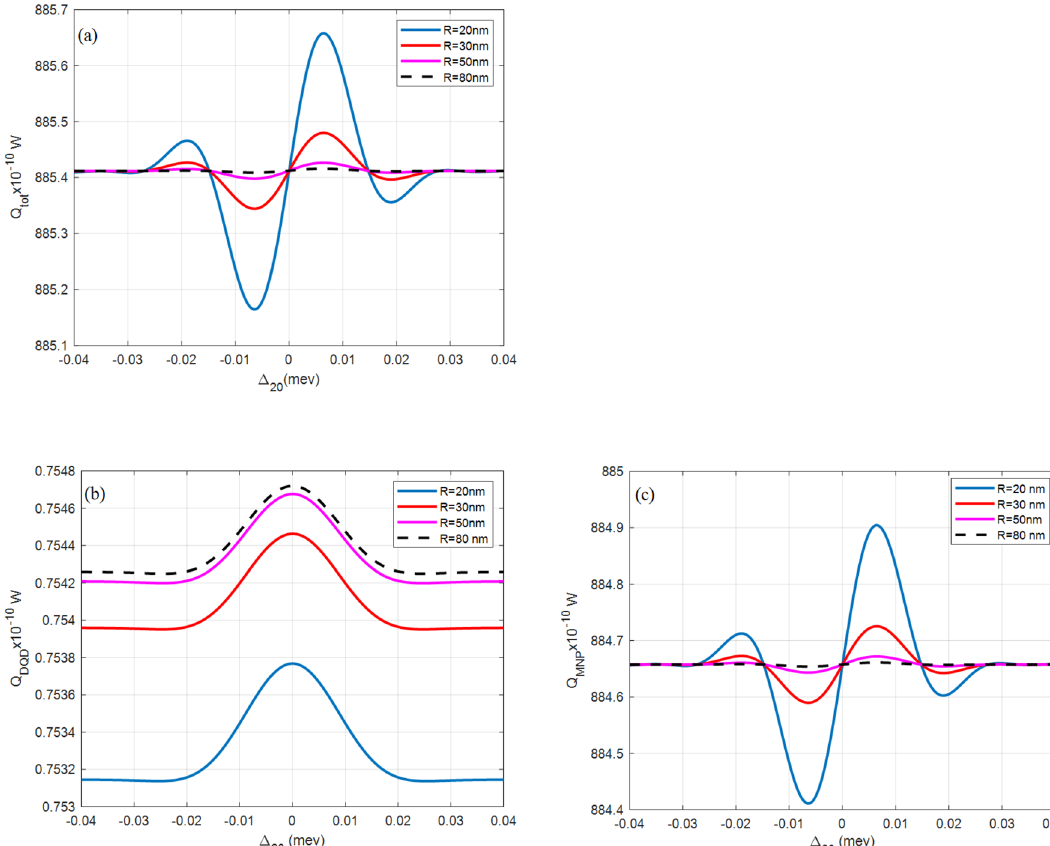
Figure 3. ( a ) The total ( Q tot ) , ( b ) DQD ( Q DQD ), and ( c ) MNP ( Q MNP ) absorption rates from the DQD-MNP hybrid system at different spacings ( R ) (the inset) with a = 10 nm, (cid:31) 0 02 = 0.09meV , (cid:31) 0 13 = 1.8GeV while the low tunneling component (pink curve) is far from them. Checking Fig. 5b and c shows that this result comes from the difference in Q DQD . Figure 6 shows Q tot at different T 23 tunneling values. A broader blue shift than that corresponds to high T 01 100 γ 0 , pink curve) the curve is inverted and reduced, referring to destruc- tunneling. At higher tunneling ( T 23 = tive interference between fields (pump, probe, and MNP polarization field). Note that this inversion is not shown in Q MNP curves while it appears in the Q DQD at tunneling less than 100 γ 0 (red curve in Fig. 6b) but not affect Q tot due to the lesser contribution of Q DQD in the Q tot . This result indicates that the synchronization between Q MNP and Q DQD is destroyed under high tunneling. Figure 7 shows Q tot at different QD sizes. Broader QD size exhibit a high absorption rate. Figure 8 shows Q tot and its components ( Q DQD , Q MNP ) at different values of the pump field (� 0 13 ) where Q tot and Q MNP are increased with increasing the pump field, contrary to the Q DQD . Figure 9 shows Q tot and its components for the single QD-MNP hybrid system (i.e., the absorption rate of a single QD ( Q SQD ) and its MNP absorption ( Q MNP ) ). Comparing this figure with the above figures (Figs. 3, 4, 5, 6, 7, 8) shows that Q tot and Q MNP are reduced by six orders while Q SQD is reduced by eight orders compared to their DQD-MNP counterpart. The high absorption rate of the DQD-MNP hybrid system comes from the transition possibilities of the DQD system, which strengthens the transitions and increases the linear and nonlinear optical properties and flexibility of choosing the transitions in the DQD system 35,38,47 . This will make the DQD-MNP hybrid system preferable to QD-MNP. Finally, the absorption rates are reexamined with a low pumping field (cid:31) 0 13 in Fig. 10. In this case, the Q DQD is higher by more than one order than the Q MNP .